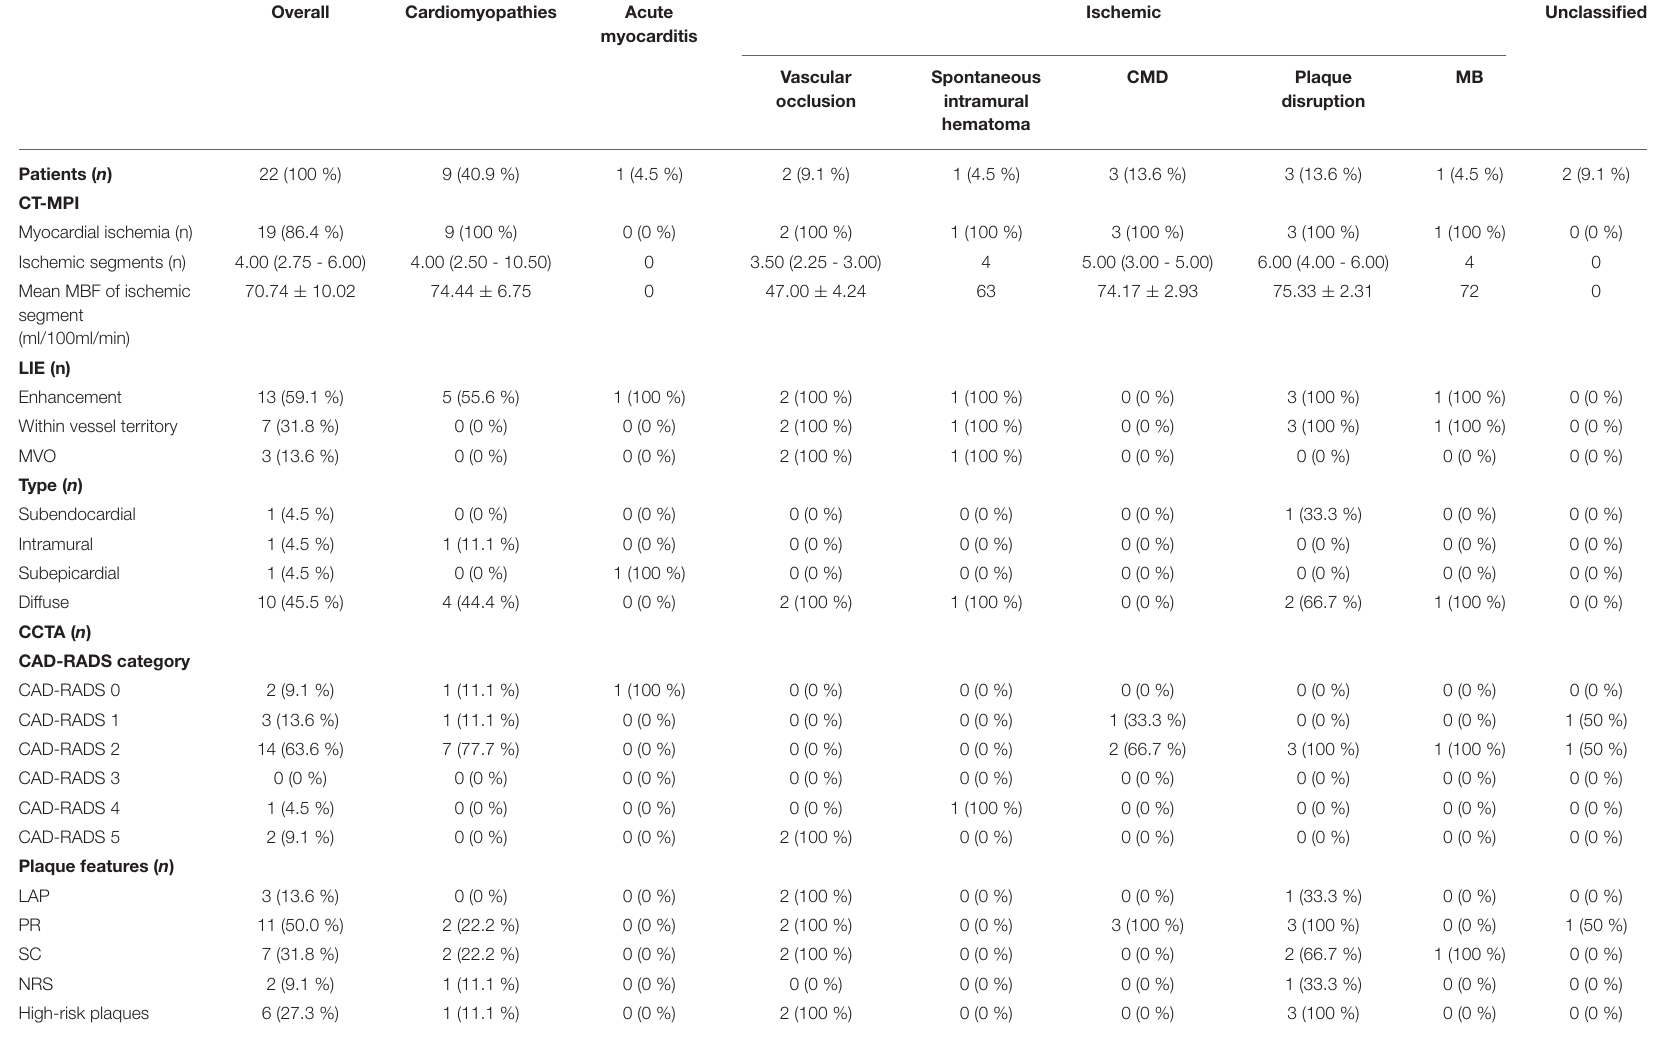
Values are mean ± SD, n (%), or median (interquartile range). CCTA, coronary CT angiography; CMD, coronary microvascular dysfunction; LAP, low-attenuation plaque; LIE, late iodine enhancement; MB, myocardial bridge; MBF, myocardial blood flow; MPI, myocardial perfusion imaging;